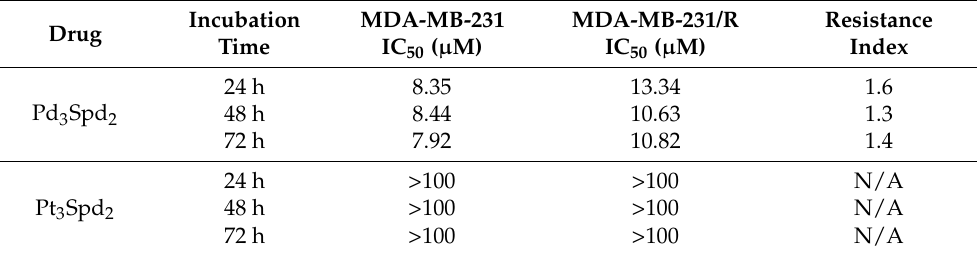
Table 1. Half-maximal inhibitory concentration (IC 50 ) of Pd 3 Spd 2 or Pt 3 Spd 2 in MDA-MB-231 and MDA-MB-231/R cells at 24, 48 and 72 h of incubation regarding the suppression of cell